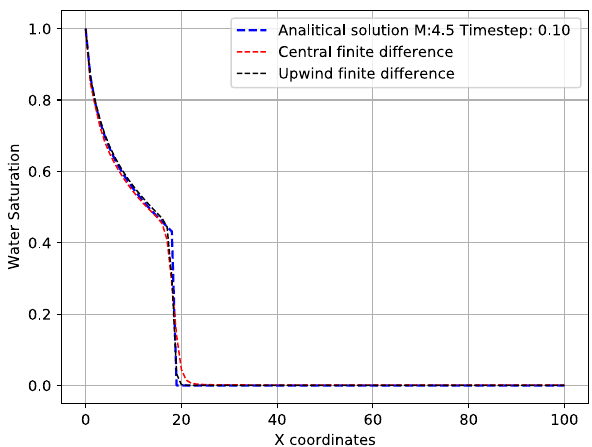
Figure 7. Comparison between solutions obtained with residuals evaluated using central and upwind finite differences, for M = 4.5